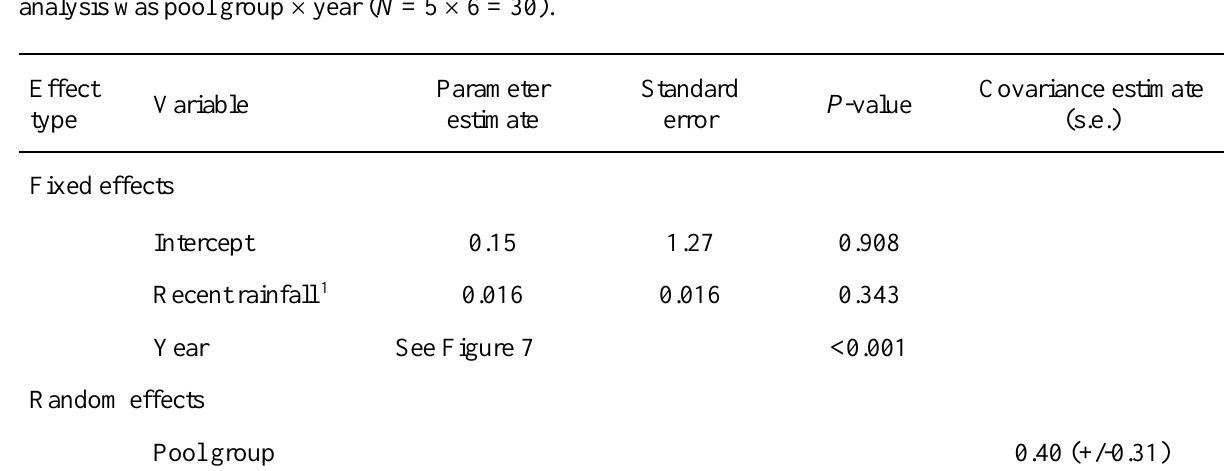
Table. 3. Statistical analysis of pool fullness. The y -variable was the number of pools in a group that were largely full, that is, had at least 50 % cover of water. The total number of pools in that pool group was the binomial denominator. Thus in effect, we analysed the proportion of pools that were largely full. The unit of analysis was pool group  year ( N = 5  6 =